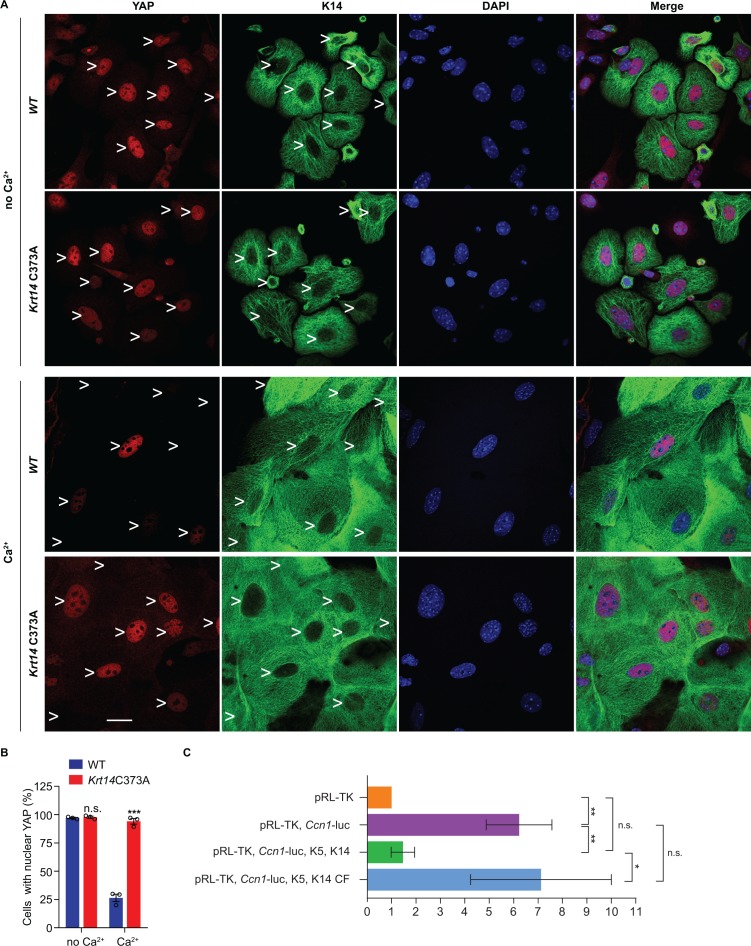
Localization and interaction of 14-3-3σ and YAP activity in Krt14 C373A keratinocytes.(A) Indirect immunofluorescence microscopy for YAP (red) and K14 (green) in WT and Krt14 C373A newborn skin keratinocytes in primary culture in the absence and presence of 1 mM calcium (for 4 d). Arrowheads depict location of nuclei. (B) Quantification of cells with nuclear YAP in frame a. N = 3 biological replicates. Approx. 100 cells were counted for each genotype for each condition. N = 3 biological replicates. Data represent mean ± SEM. Student’s t test: n.s., no statistical difference; ***p<0.005. Scale bars, 20 µm. (C) Luciferase assays in HeLa cells transfected with a Ccn1-Luciferase reporter construct (see Materials and methods). Data were normalized with regard to transfection efficiency and signal obtained with pRL-TK vector control. Data represent mean ± SEM three biological replicates consisting of 6 technical replicates each. Mann-Whitney tests were performed to compare each parameter using GraphPad Prism 8. **p<0.01, *p<0.05, n.s., non-significant.